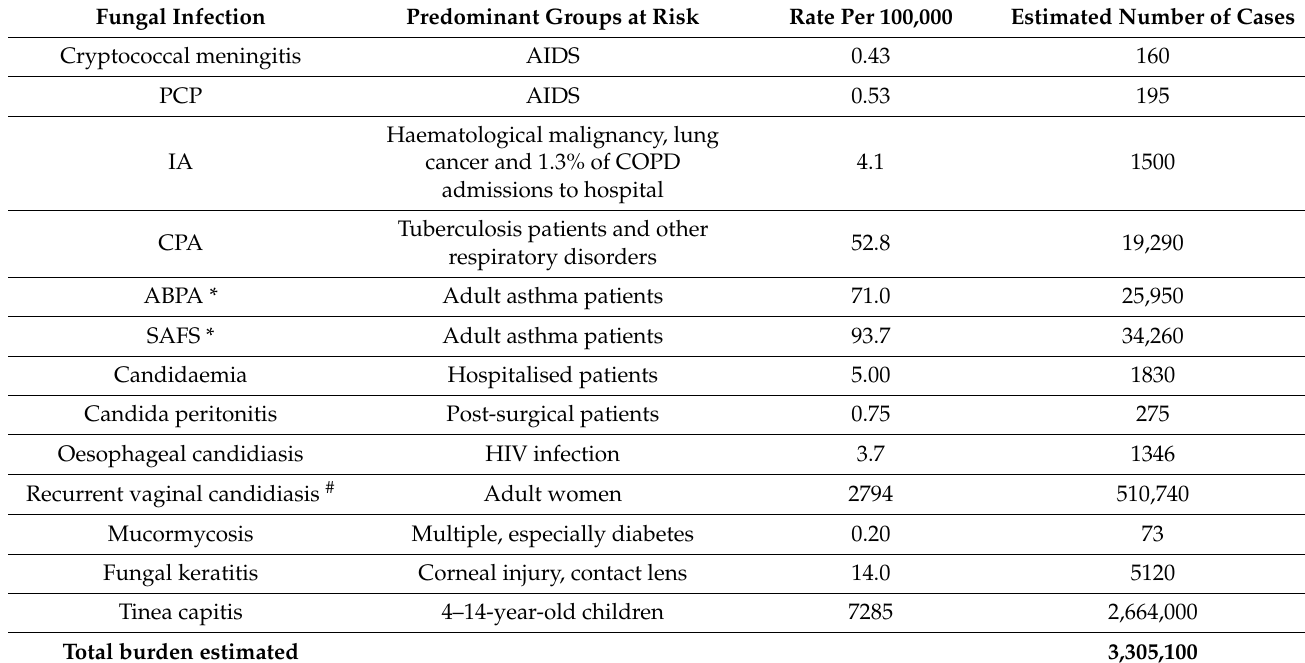
Table 1. The estimated annual caseload (incidence or prevalence) of serious fungal infections in Morocco and number per 100,000